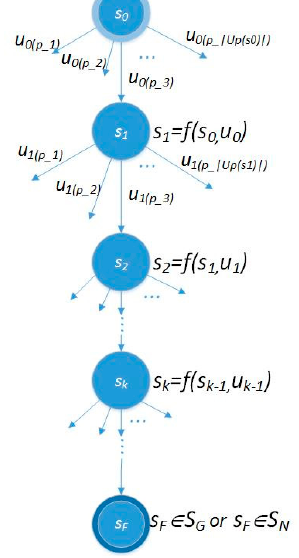
Figure 1. Single trajectory constructing.